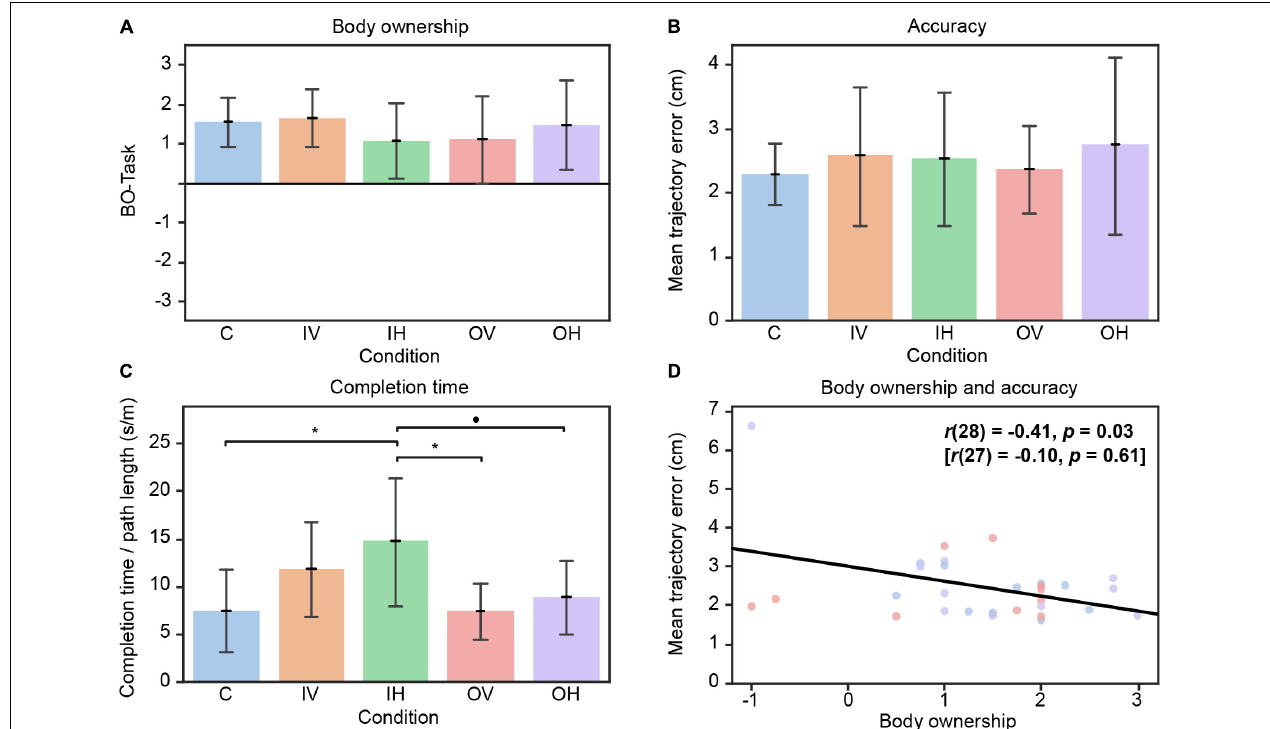
FIGURE 4 | Results Block 2. (A) Means of the subscale body ownership (Q1–Q4) from embodiment questionnaire after Task 2 per condition. (B) Mean trajectory error over all trials of Task 2 per condition. Higher values indicate lower accuracy. (C) Mean completion time divided by the path length over all trials of Task 2 per condition. (D) Association of accuracy during Task 2 and BO-Task. Results in brackets represent data after removal of the outlier. C = congruent; IV = incongruent visual; IH = incongruent haptic; OV = only visual, OH = only haptic. Error bars represent standard deviation. • p < 0.10. * p <